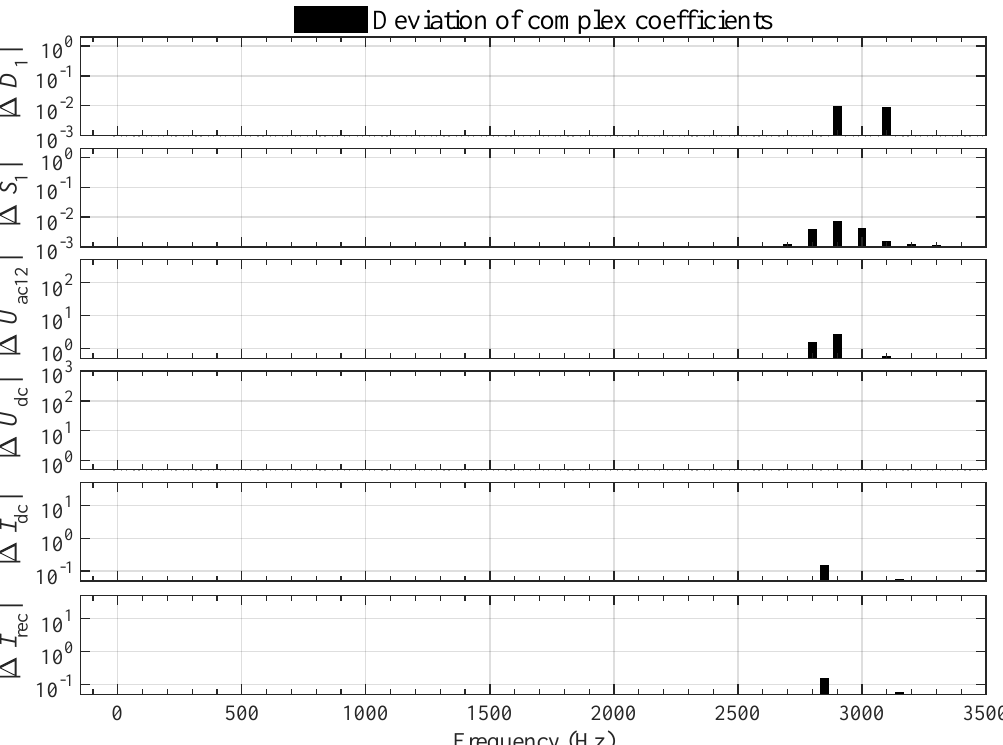
Figure 12. Deviation of the complex spectra of the frequency-domain model from the time-domain model presented in Figure 11 for closed-loop control.